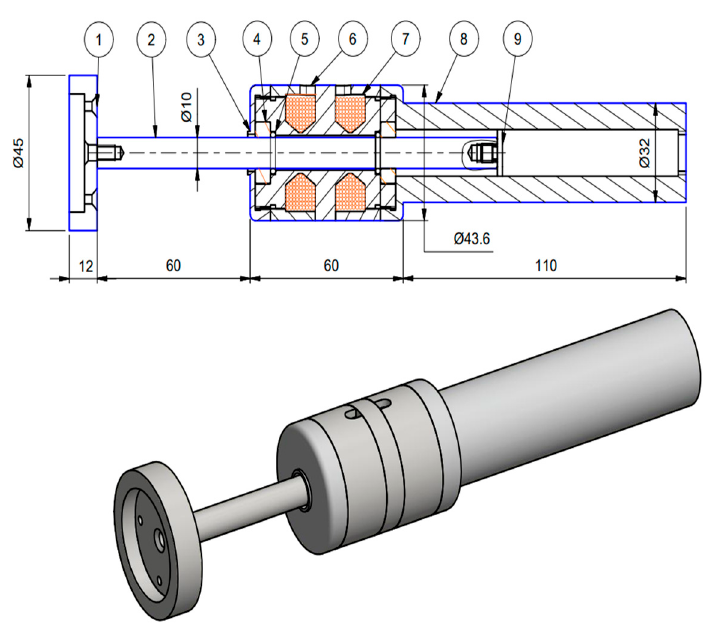
Figure 11. Assembly design of the linear MR brake.